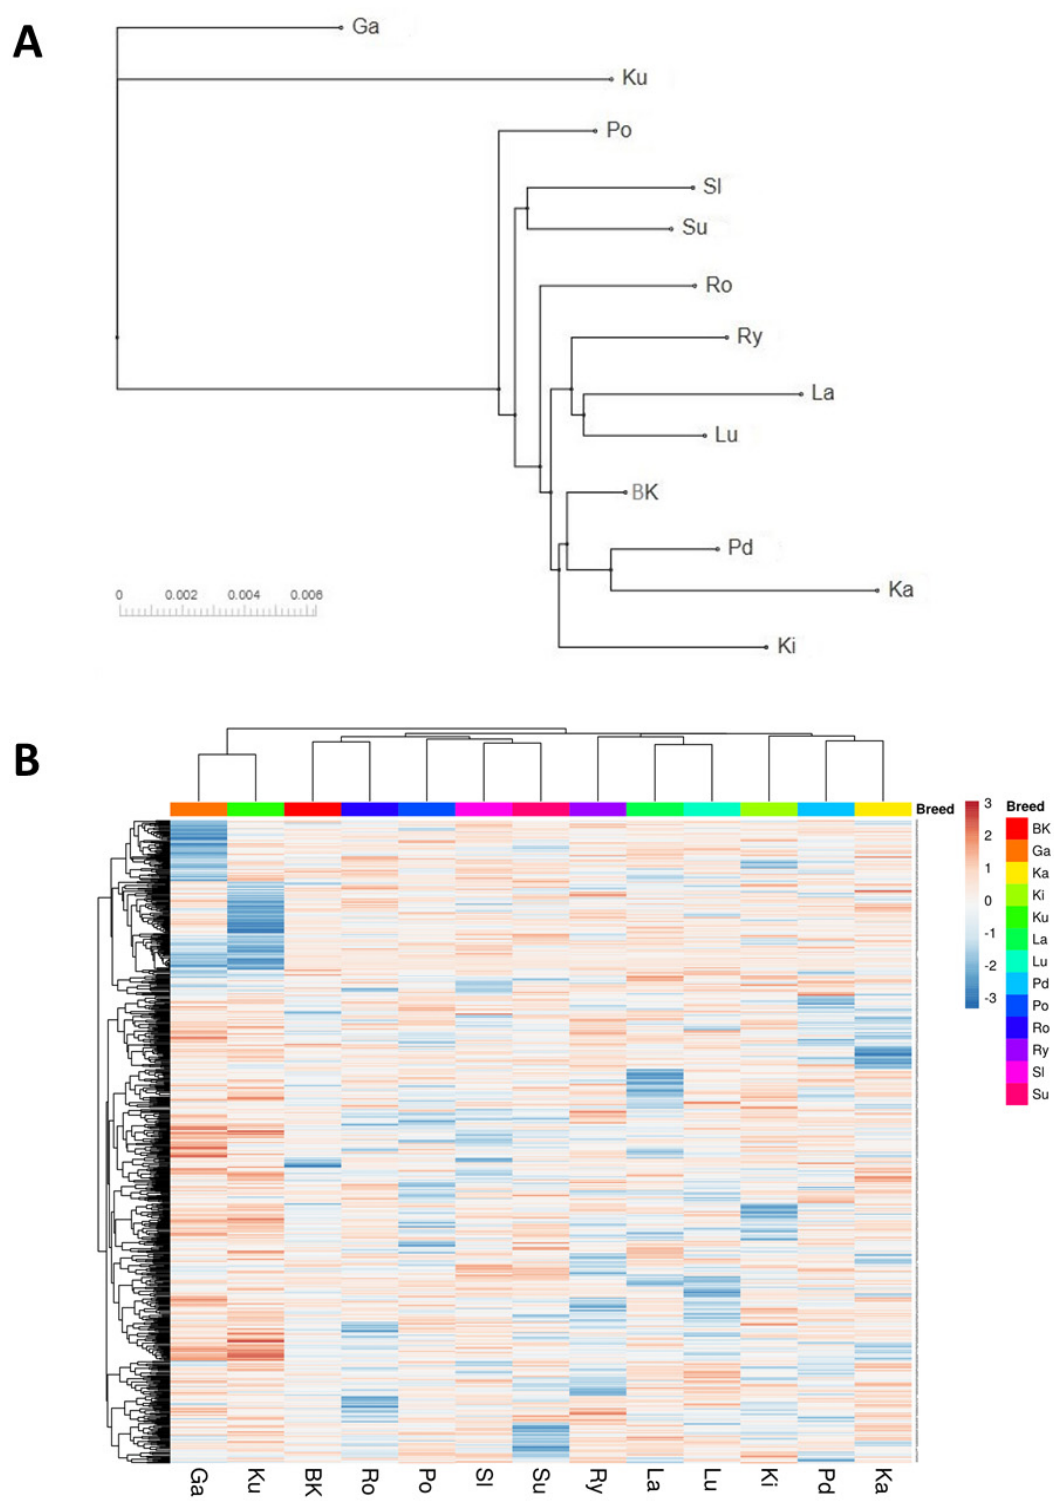
Figure 2. Cladogram created based on Nei’s genetic distances ( A ) and a frequency heatmap along with the hierarchical clustering of breeds and SNPs ( B ) (White Kołuda ® (BK), Kielecka (Ki), Podkarpacka (Pd), Garbonosa (Ga), Pomorska (Po), Rypinska (Ry), Landes (La), Lubelska (Lu), Suwalska (Su), Kartuska (Ka), Romanska (Ro), Slowacka (Sl) and Kubanska (Ku)).